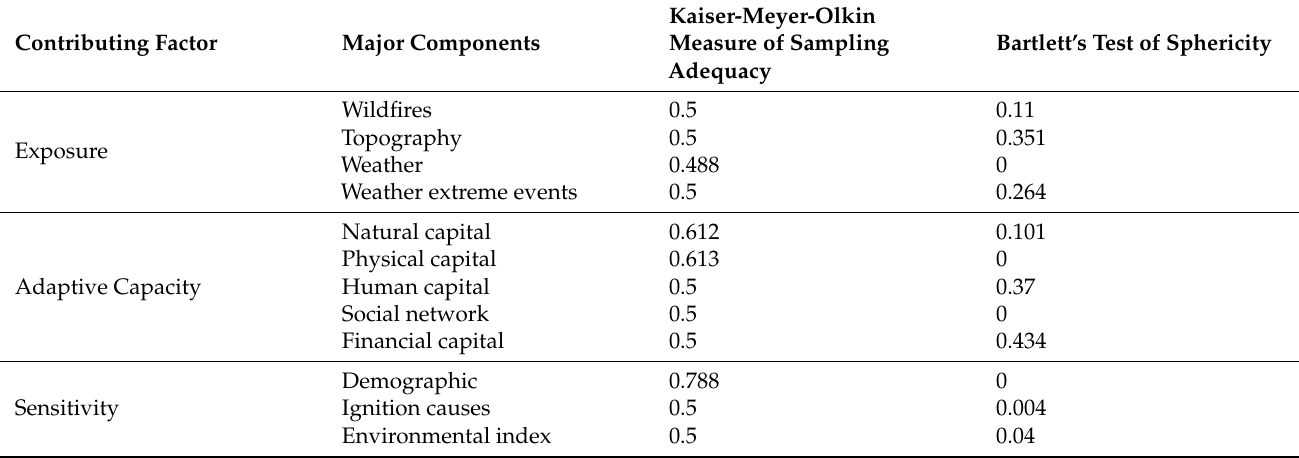
Table A4. The Kaiser- Meyer-Olkin (KMO) measure of sampling adequacy and Bartlett’s Test of Sphericity results for each contributing factor of exposure, adaptive capacity, and sensitivity.